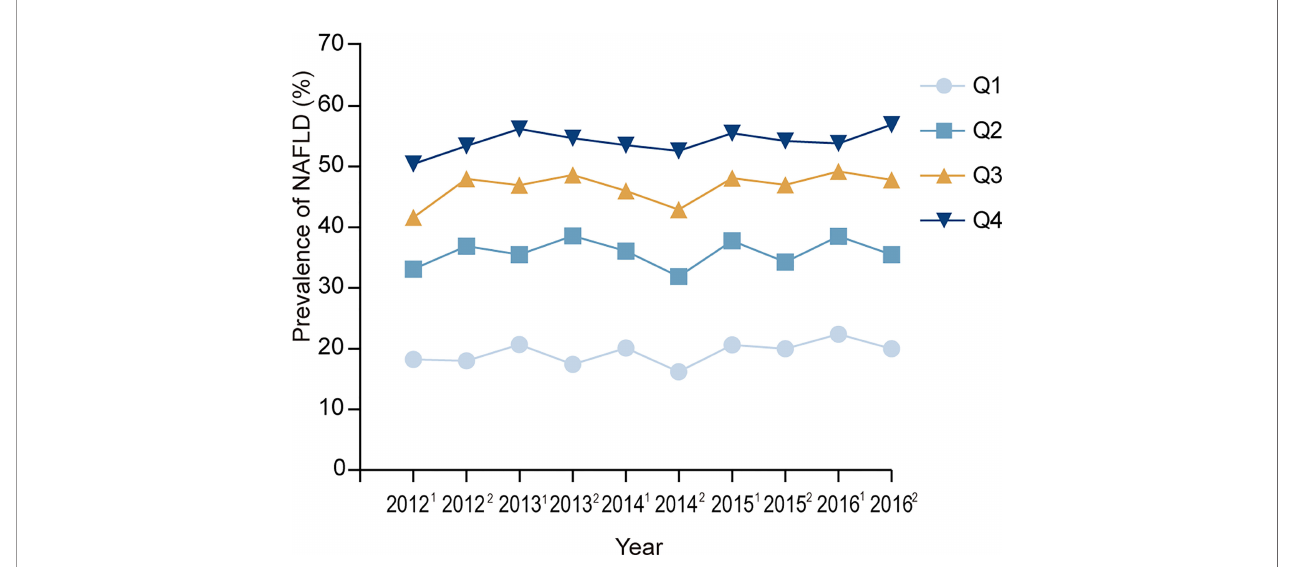
FIGURE 2 | Prevalence of NAFLD at each visit time point. 2012 1 , 2012 2 , 2013 1 ,2013 2 , …… 2016 1 ,2016 2 represent the fi rst half of 2012, the second half of 2012, the fi rst half of 2013, the second half of 2013, …… the fi rst half of 2016, and the second half of 2016. Q1, Q2, Q3, Q4 represent the lowest quartile, second quartile, third quartile, highest quartile of RBC count